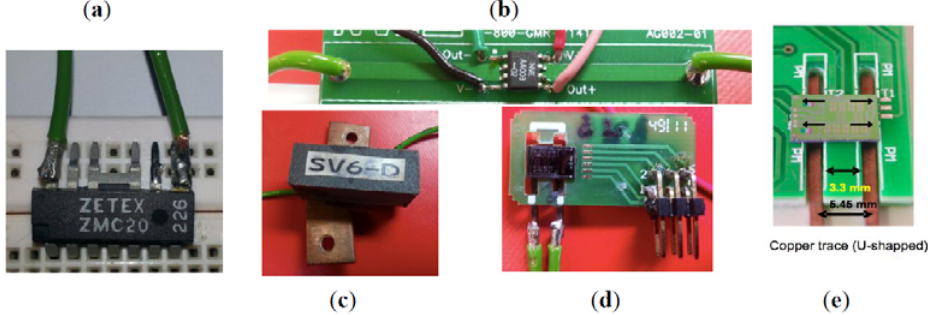
Figure 6. Actual appearance of the tested MR sensors. ( a ) AMR sensor (ZMC20); ( b ) GMR sensor (AA003-02); ( c ) GMR-SV sensor (INESC-MN, Lisbon, Portugal); ( d ) TMR-without magnets (INL, Braga, Portugal) and ( e ) TMR-with magnets